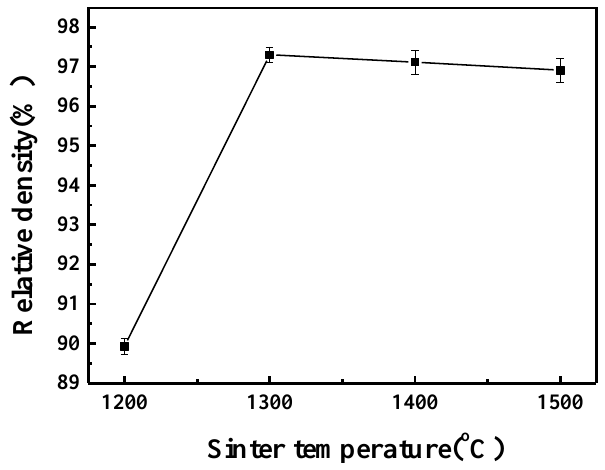
Figure 3. Relative density of the TiB 2 –5 wt% (Fe–Ni–Ti–Al) composites sintered at different temperature.